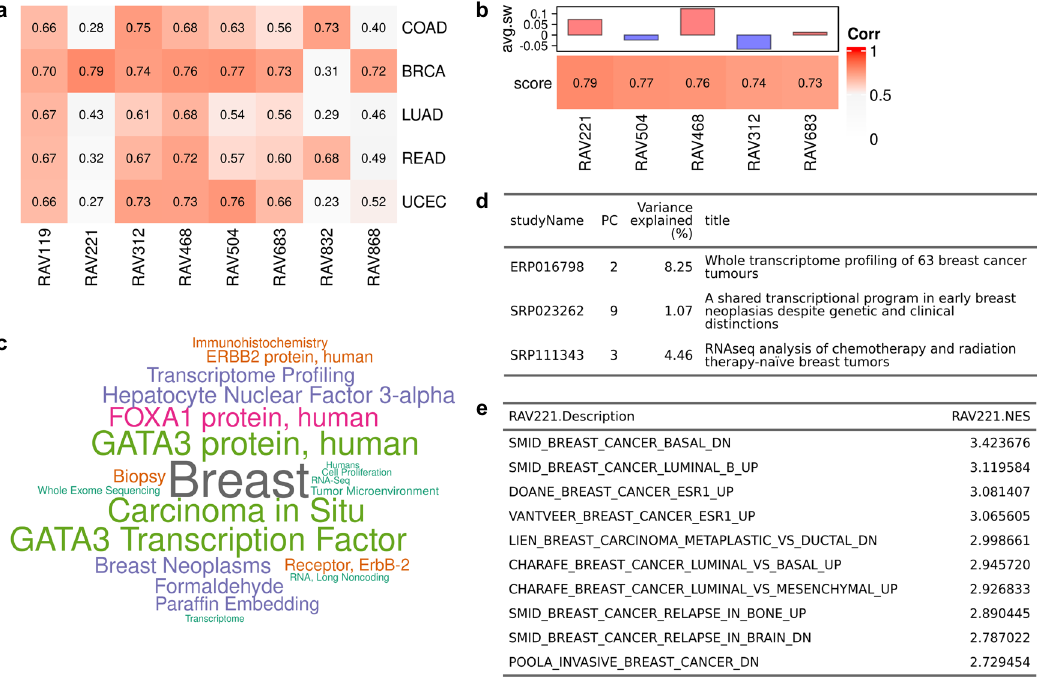
Fig. 2 Connecting new datasets to existing databases. a GenomicSuperSignature provides a rich resource for understanding new or user-supplied datasets in the context of existing datasets summarized in the RAVmodel. a Validation of multiple TCGA RNA-seq datasets. Each dataset was subjected to PCA and Pearson correlation coef fi cients between top PCs and all possible RAVs were calculated. RAVs with Pearson coef fi cients above 0.7 in at least one dataset were displayed here. RAV221 and RAV868 indicate association with breast cancer while RAV832 is associated with colon and rectal cancer. (COAD: Colon Adenocarcinoma, BRCA: Breast Invasive Carcinoma, LUAD: Lung Adenocarcinoma, READ: Rectum Adenocarcinoma, UCEC: Uterine Corpus Endometrial Carcinoma) b Validation of TCGA-BRCA. From panel ( a ), we showed RAV221 is associated with breast cancer and con fi rmed RAV221 is one of the top validated RAVs for TCGA-BRCA. Top 5 validated RAVs ( score , bottom panel) and their average silhouette width ( avg.sw , top panel) are